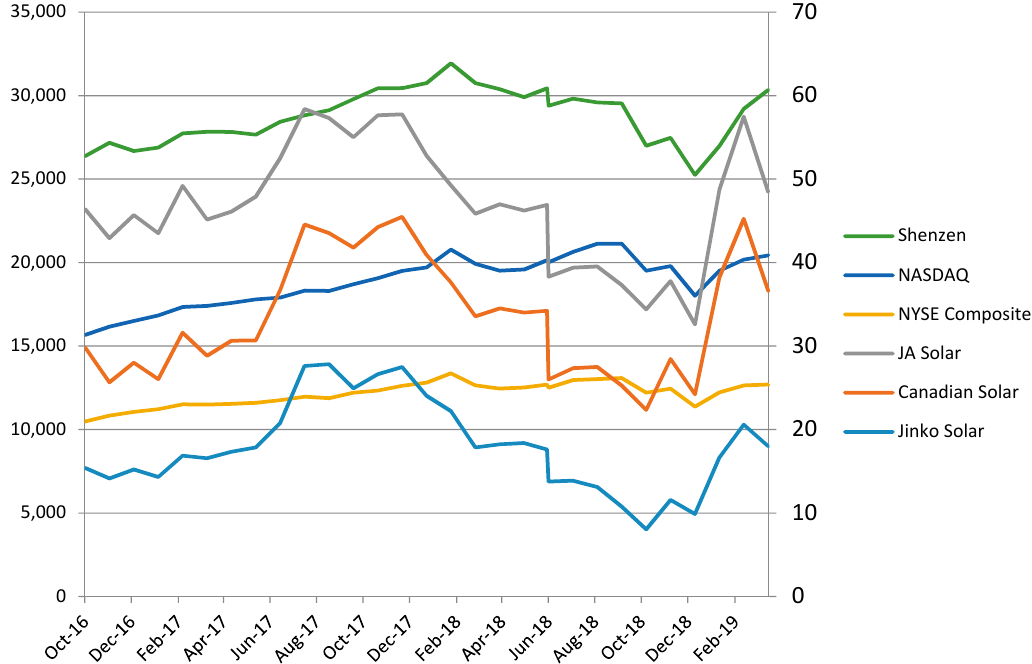
Figure 8. The stock valuation of Jinko Solar (USD), JA Solar (CNY), Canadian Solar (USD), and NYSE, NASDAQ, Shenzhen index (points) (Sourced: based on yahoo finance database).